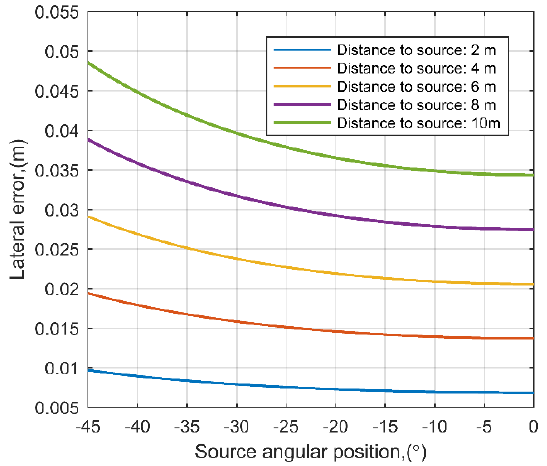
Figure 12. The analytically estimated lateral error dependence on source angular position and distance in case of time measurement error of ± 1 µ